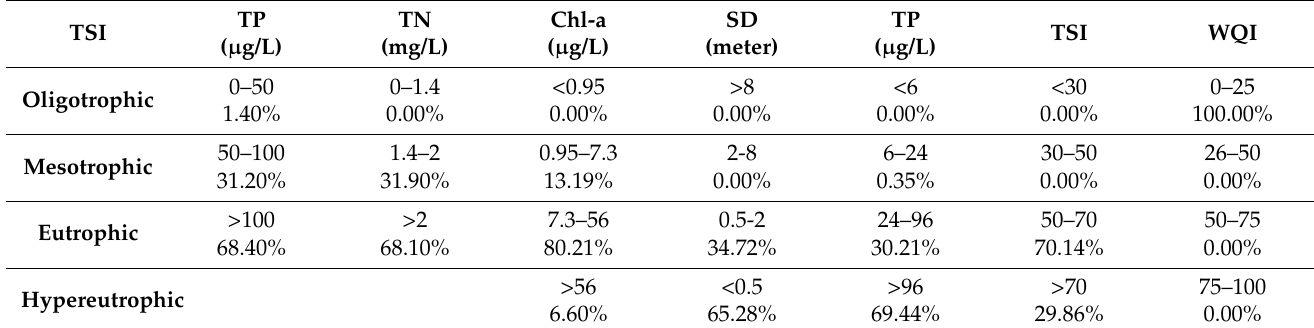
Table 2. The ranges of TP and TN, and the trophic state and